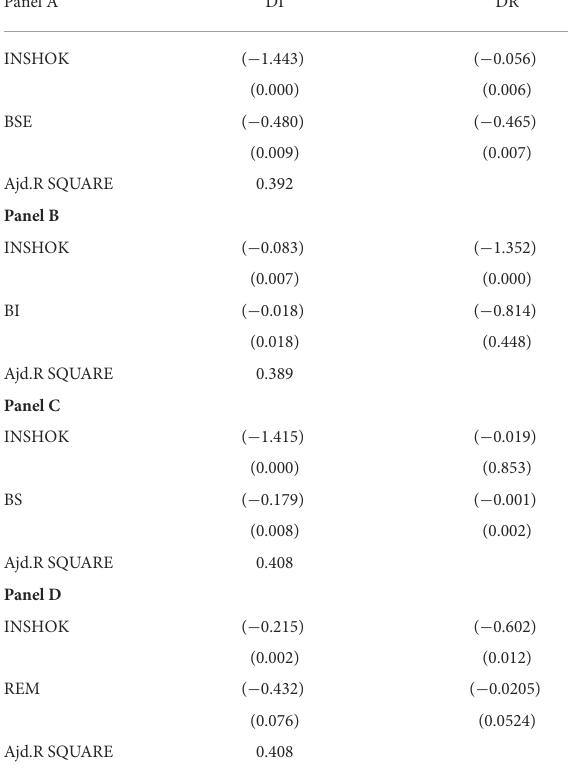
TABLE 4 Corporate governance, CEO remuneration, and banks pay out policy in case of income